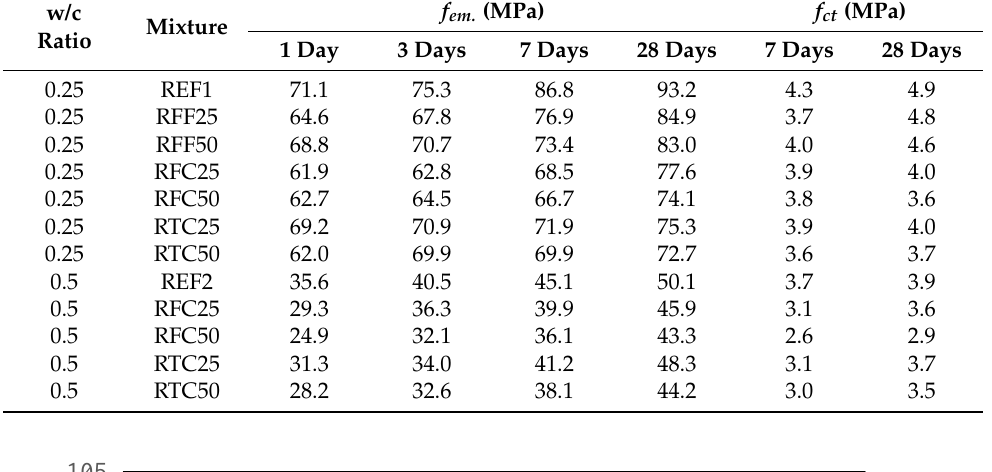
Table 5. Compressive and splitting tensile strength of concrete mixtures.